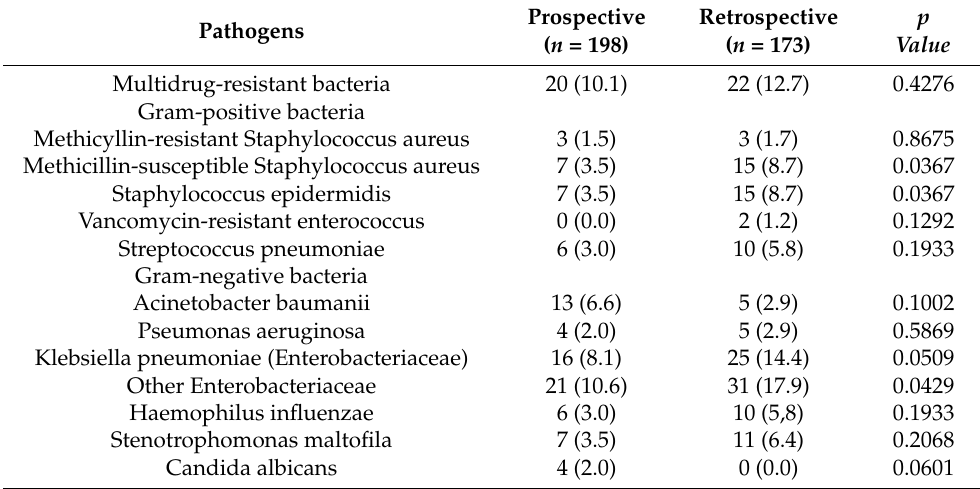
Table 3. Microbiologic pathogens isolated from the lower respiratory secretions of patients in the prospective and retrospective